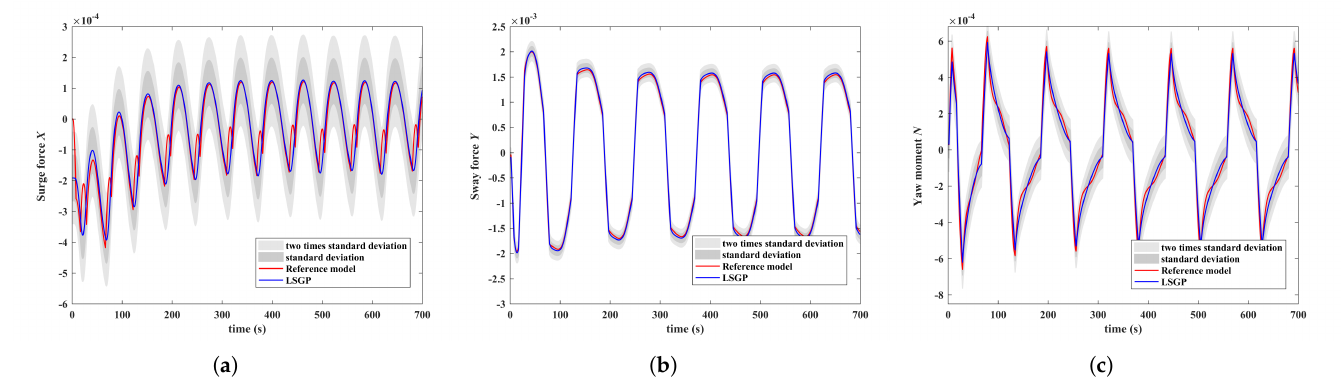
Figure 5. Comparison results of non-dimensional with the simulated ZZ-30 ◦ -5 ◦ test. ( a ) is about the Surge force of the “mariner”; ( b ) is about the Sway force of the ship; ( c ) is the situation of Yaw moment of the ship; the figure shows one and two times the standard deviation bandwidth respectively.